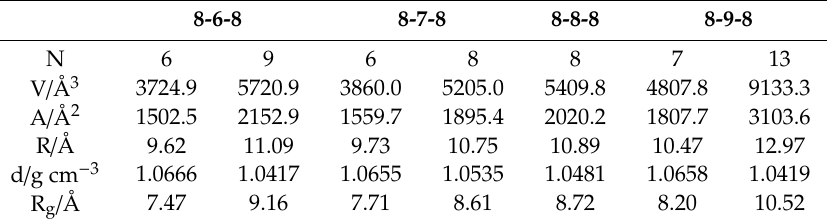
Micelle parameters obtained from simulations based on Conductor-like Screening Model